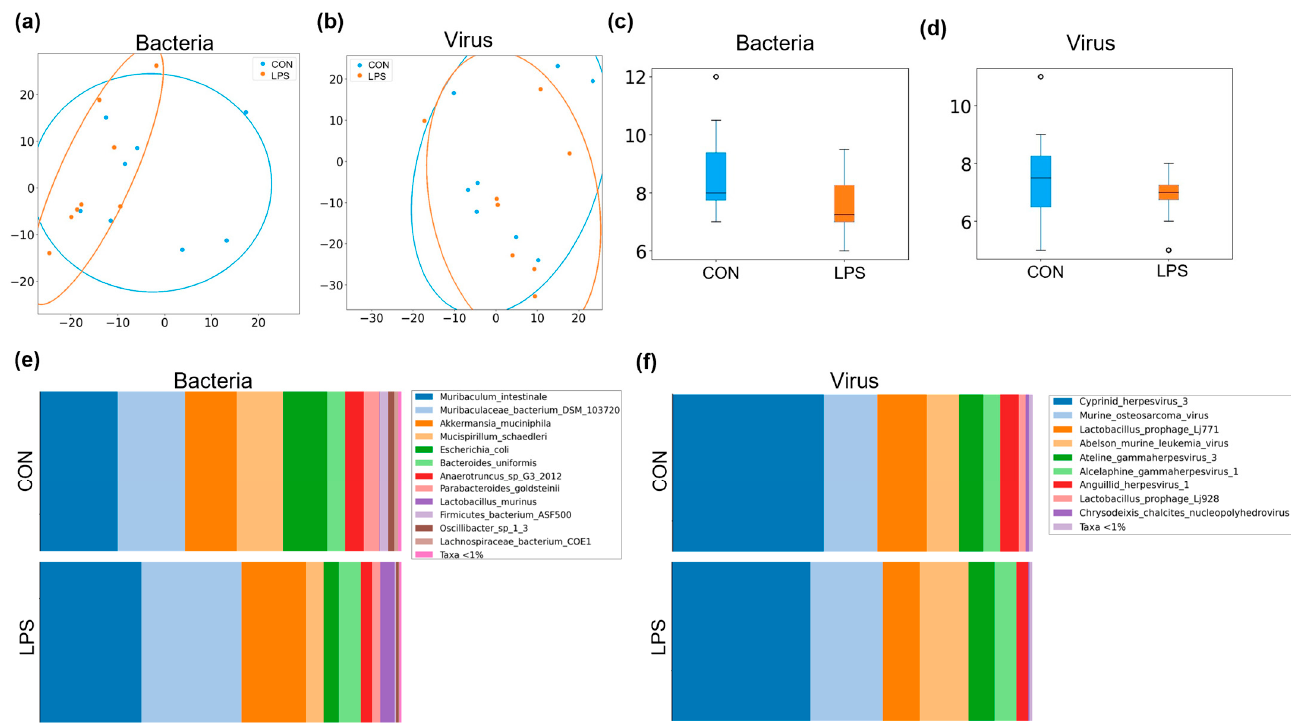
Figure 4. Summary of the microbiome statistical analysis in the LPS-induced inflammation model. Beta diversity: PCA plot calculated by Aitchison distance for bacteria ( a ) and virus ( b ). Alpha diversity (AU): chao1 index in bacteria ( c ) and virus ( d ). Taxonomic differences represented as relative distribution of species in bacteria ( e ) and virus ( f ); these figures show a bar graph at the level of both bacterial and viral species (relative %), comparing the animals in all groups. Blue represents CON group and orange LPS group ( n = 8 animals per group).